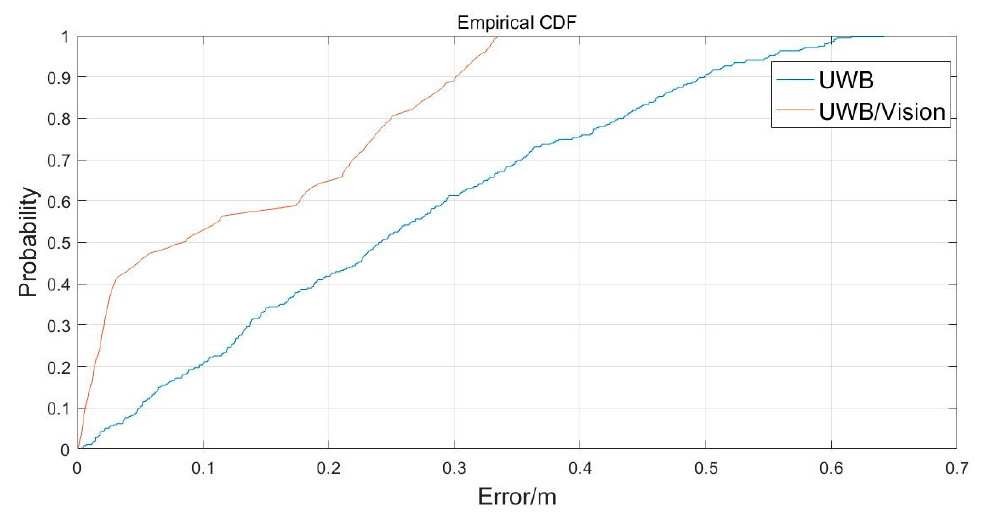
Figure 17. The cumulative distributions of plane errors.